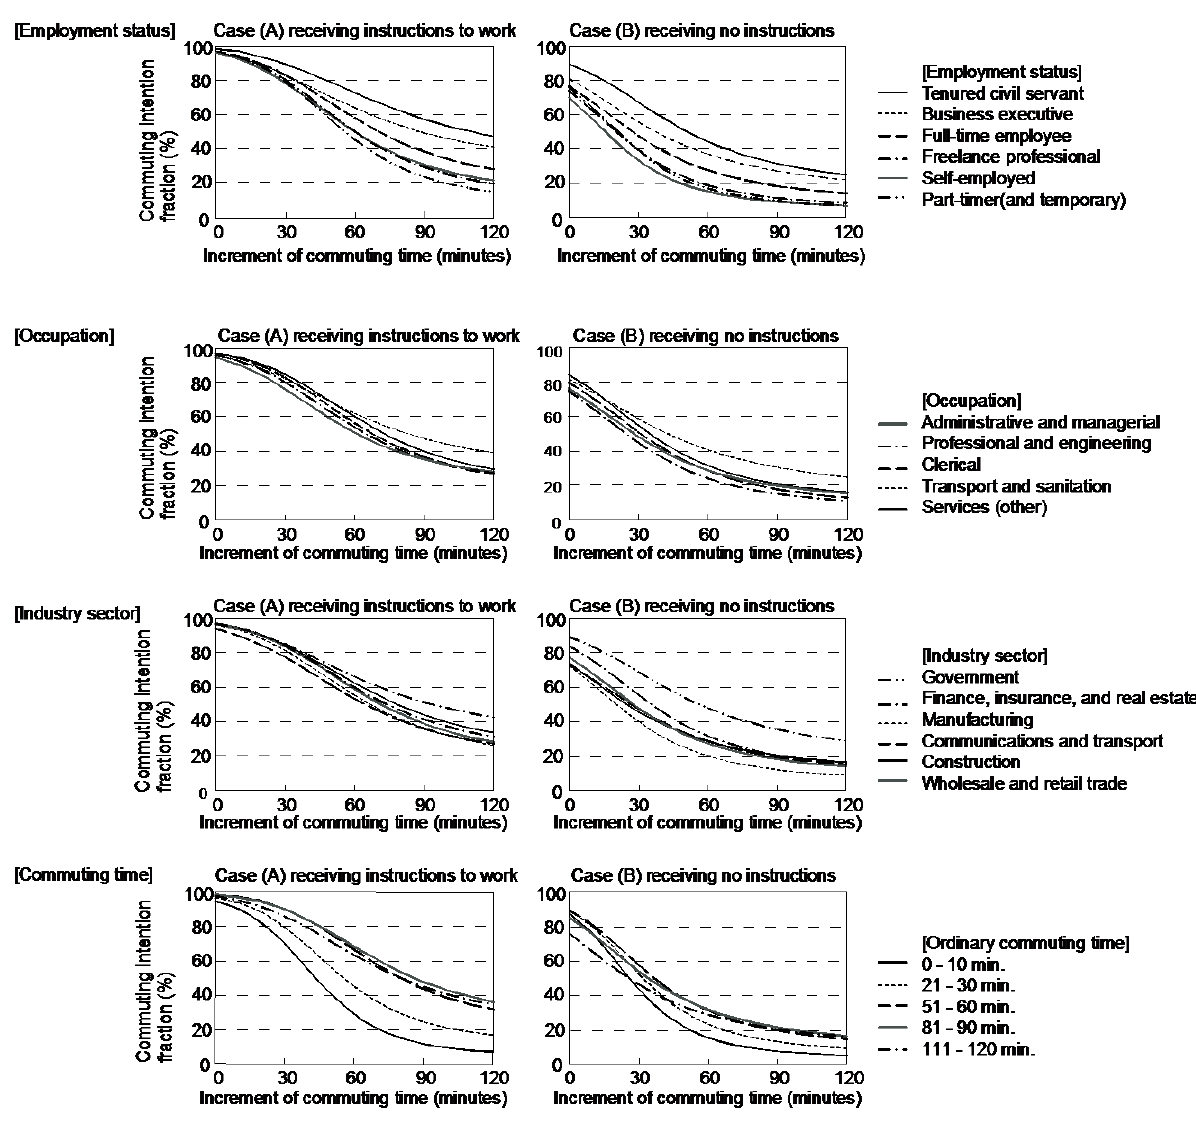
Figure 5. Estimated value of commuting intention percentages expressed in terms of employment conditions and ordinary commute